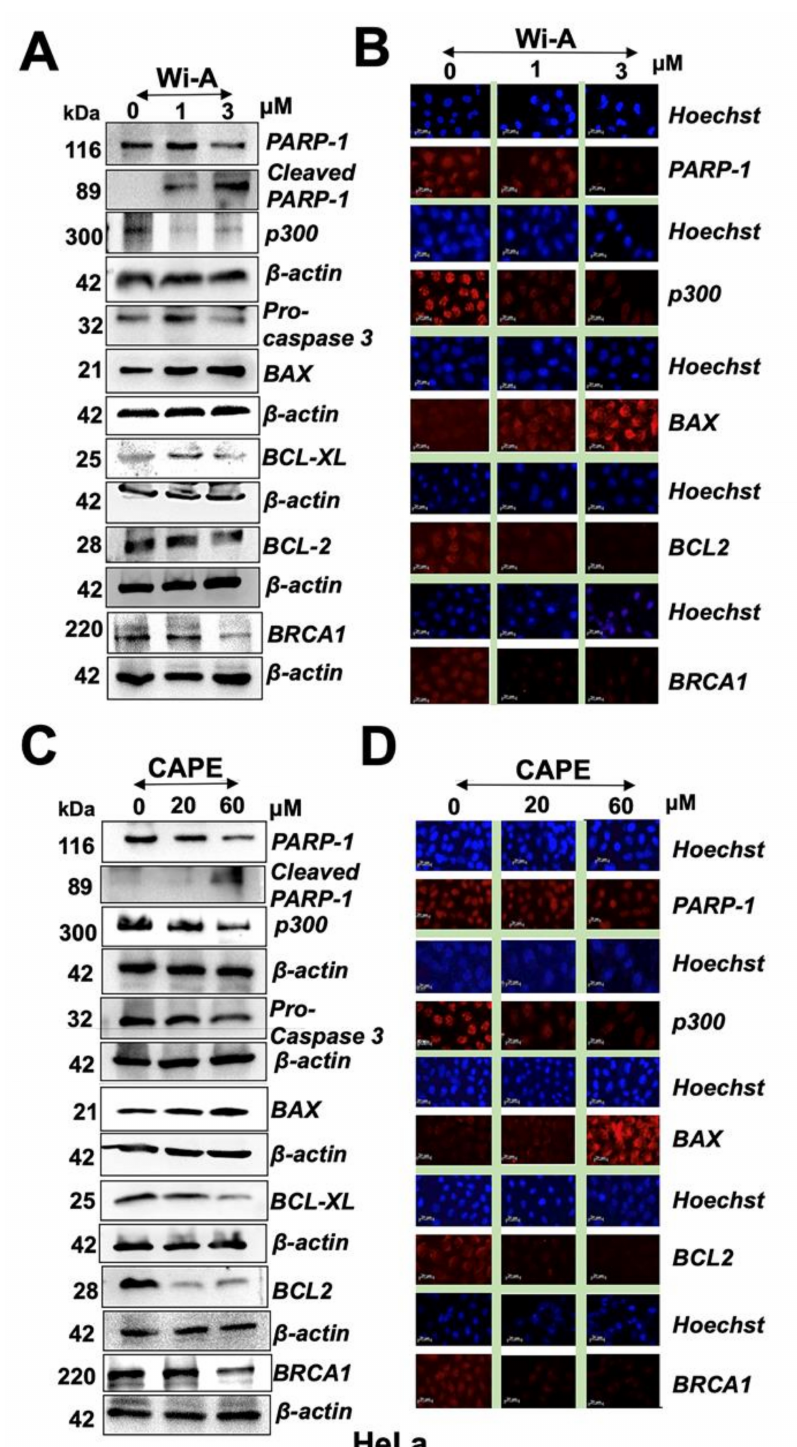
Figure 3. Withaferin A (Wi-A) and ca ff eic acid phenethyl ester (CAPE) triggered poly ADP-ribose polymerase1 (PARP1) cleavage and apoptosis signaling. Wi-A ( A , B ) and CAPE ( C , D )-treated cells showed decrease in PARP1, p300, pro-caspase 3, B-cell lymphoma 2 (Bcl-2), B-cell lymphoma-extra large (Bcl-xL), and breast cancer type 1 susceptibility protein (BRCA1) as detected by Western blotting ( A , C ) and immunostaining ( B , D ); Scale bar-20 µ M. Each data set represents the mean ± SD for at least three independent biological